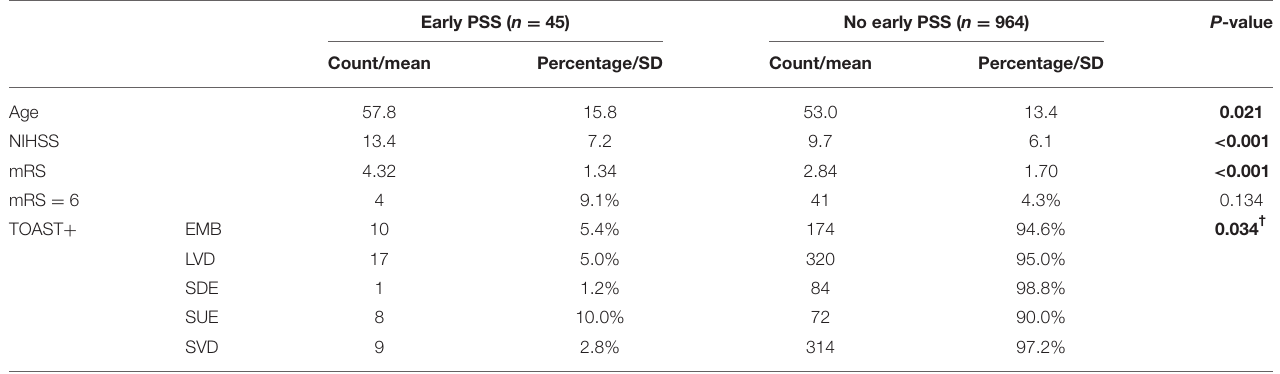
TABLE 3 | Age, NIHSS, TOAST criteria of ischemic stroke, and mRS score upon discharge comparison between seizure and non-seizure